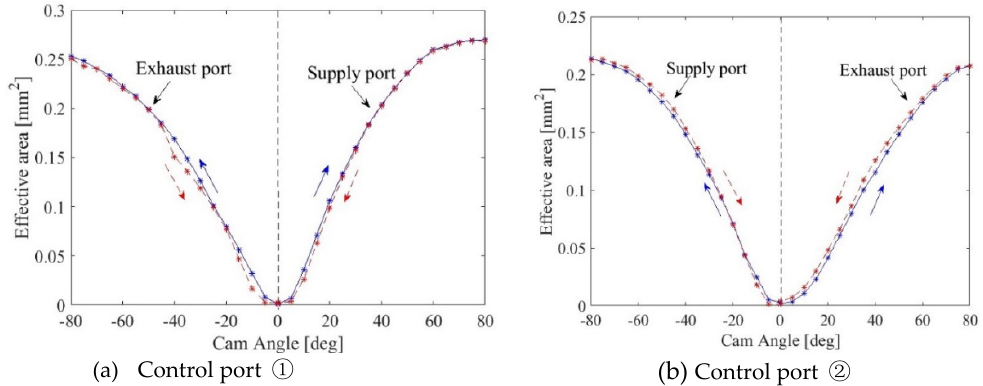
Figure 10. Flow characteristics of previous prototype pinch valve.